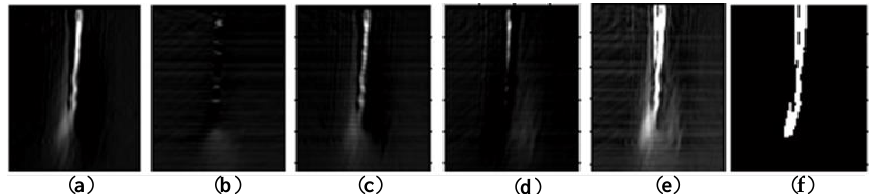
Figure 10. ( a ) Gradient in the x-direction ( b ) Gradient in the y-direction ( c ) Gradient in the d 1 direction, ( d ) Gradient in the d 2 direction, ( e ) Gradient magnitude, ( f ) Otsu’s thresholding.